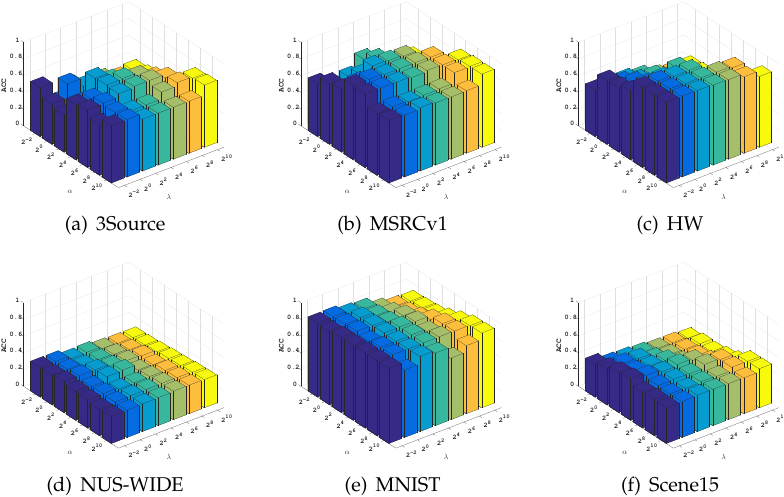
Figure 3. The ACC performance for different λ and α (when β = 1).